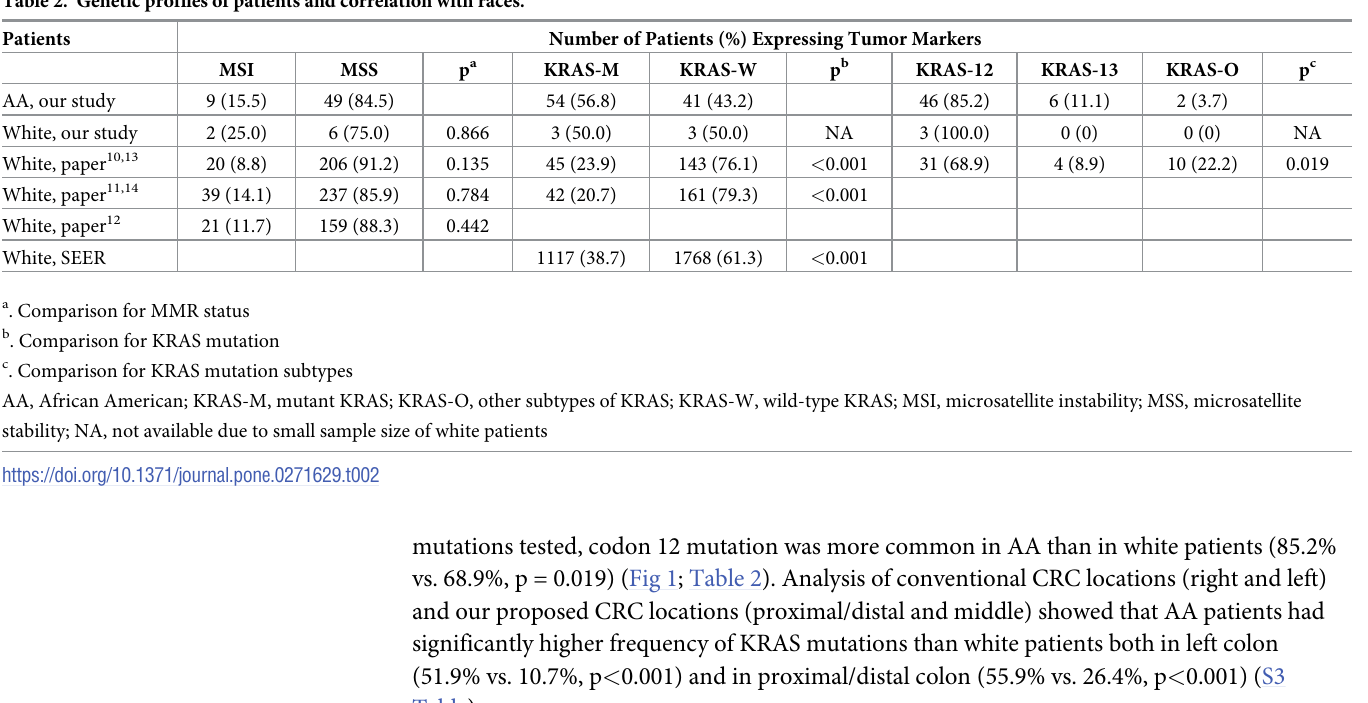
Table 2. Genetic profiles of patients and correlation with races.